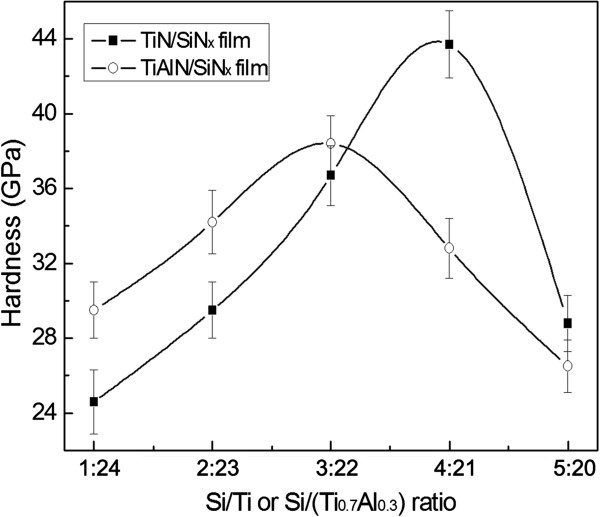
Variation of hardness of TiN/SiNx and TiAlN/SiNx nanocomposite films with change of Si content.